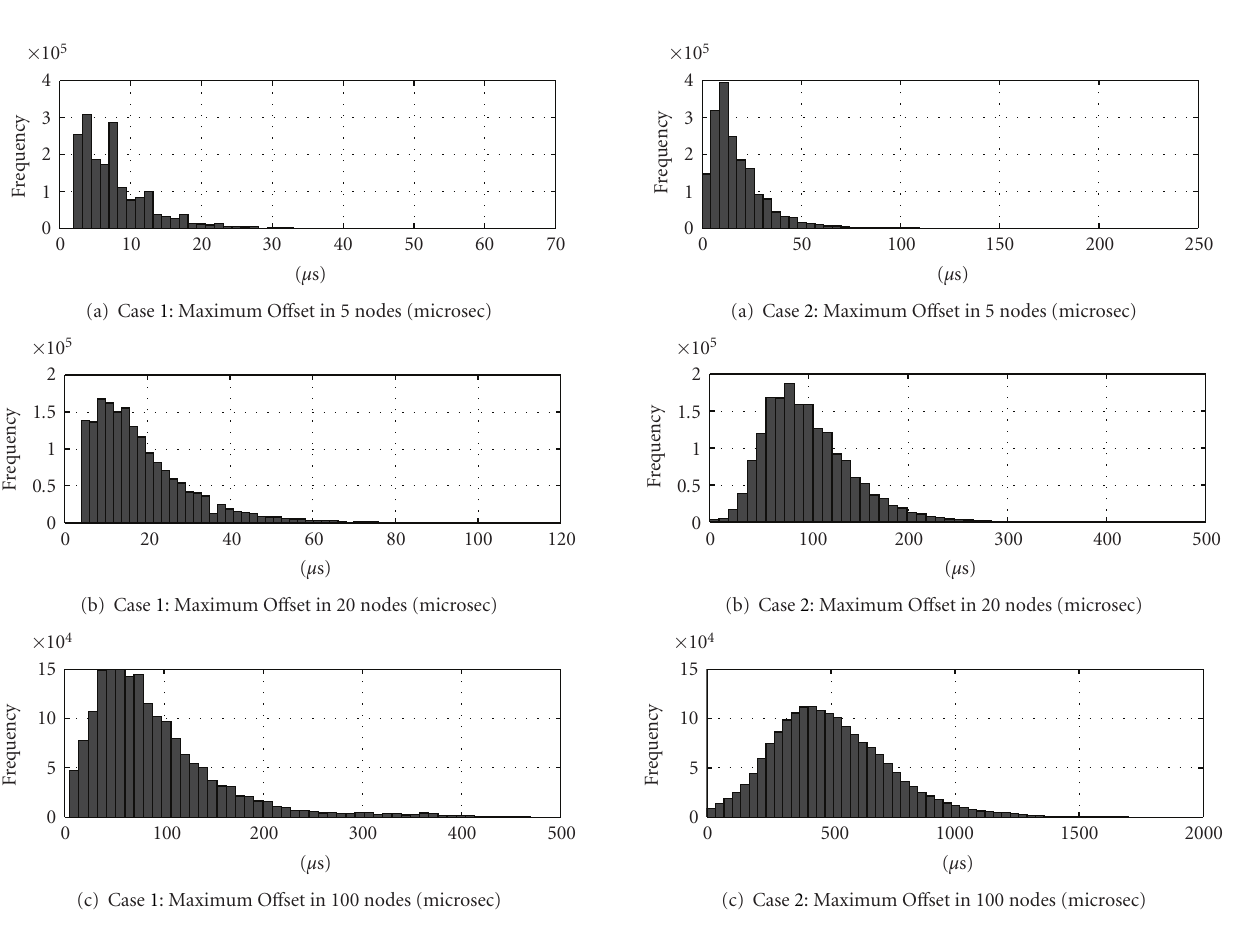
Figure 5: Configuration of wireless nodes.